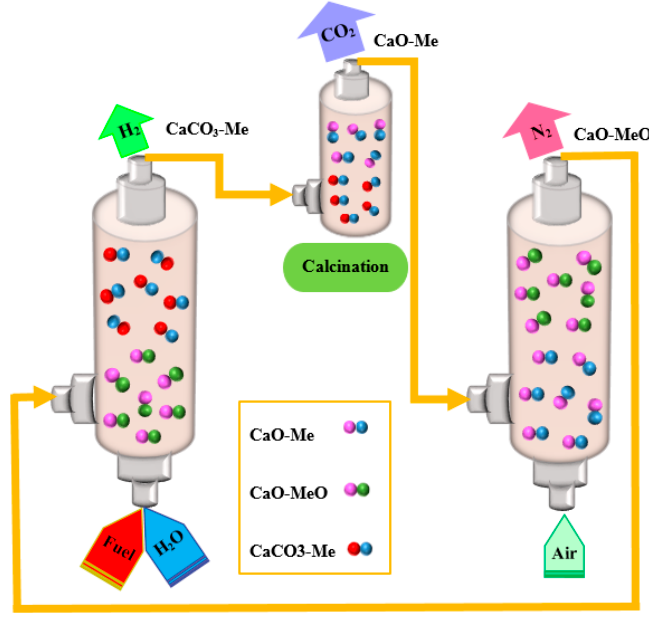
Figure 1. Conceptual scheme of modified chemical looping steam methane reforming process.